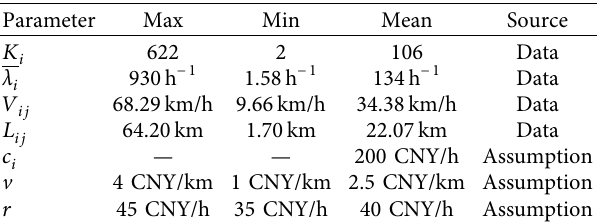
Figure 3: Spatial distribution of on-demand ride requests in Hangzhou, China. Table 2: Summary of parameters based on empirical data